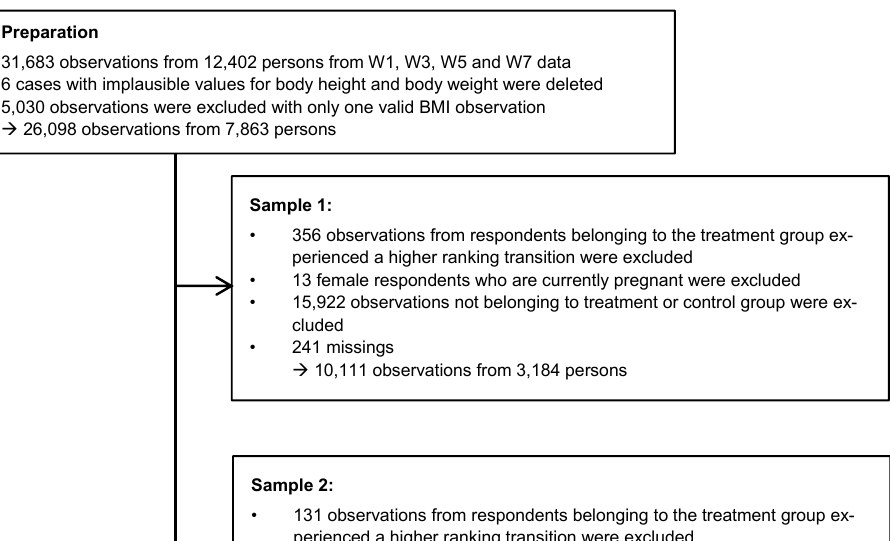
Figure A1 : Study flow